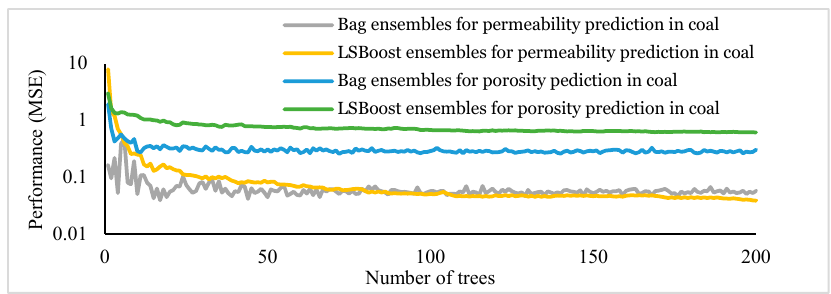
Figure 15. Prediction error versus the number of trees for statistical ensembles in the studied unconventional coal reservoir.